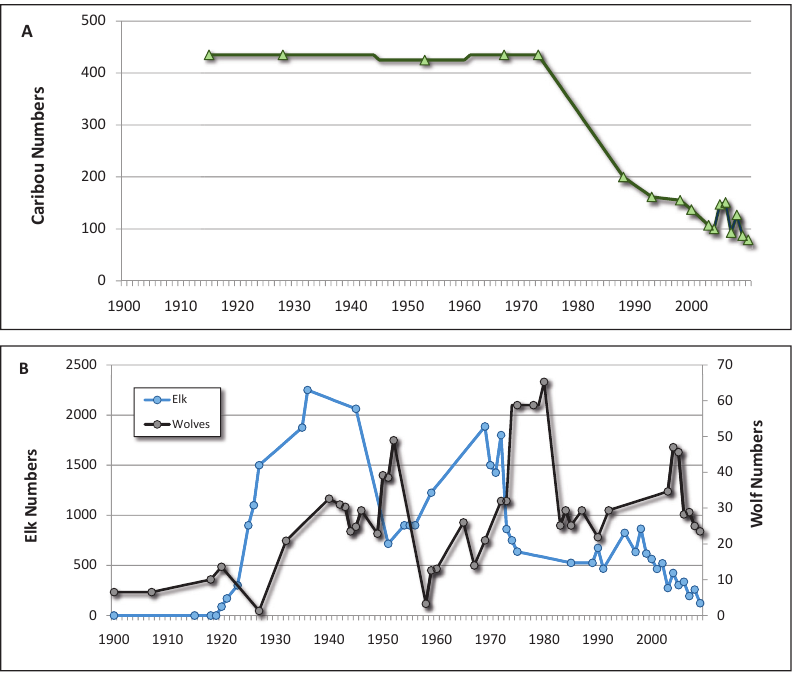
Fig. 3. Trends in approximate abundance of caribou (A), elk (B), and wolves (B), in Jasper National Park from 1900 to 2009. Elk were reintroduced in 1920 while predator control was ongoing (1900-1959). Severe winters affected the elk population in the late 1940s and early